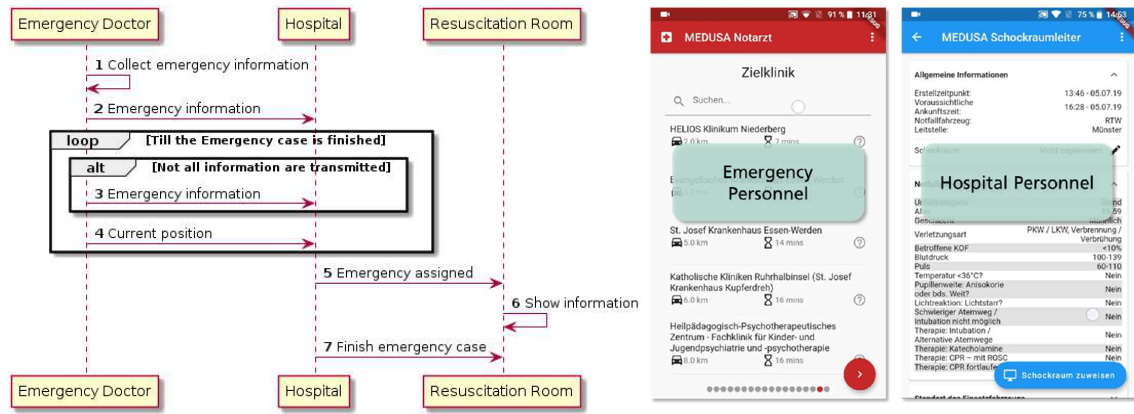
Figure 3. Simplified emergency process using digital applications.